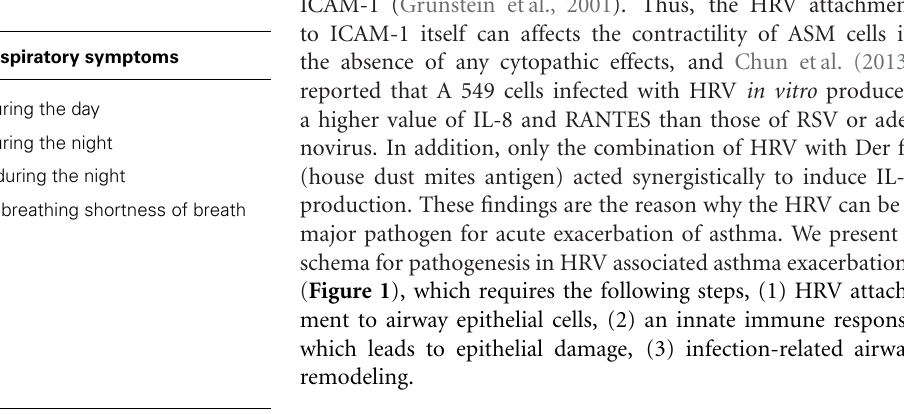
Table 2 | Respiratory